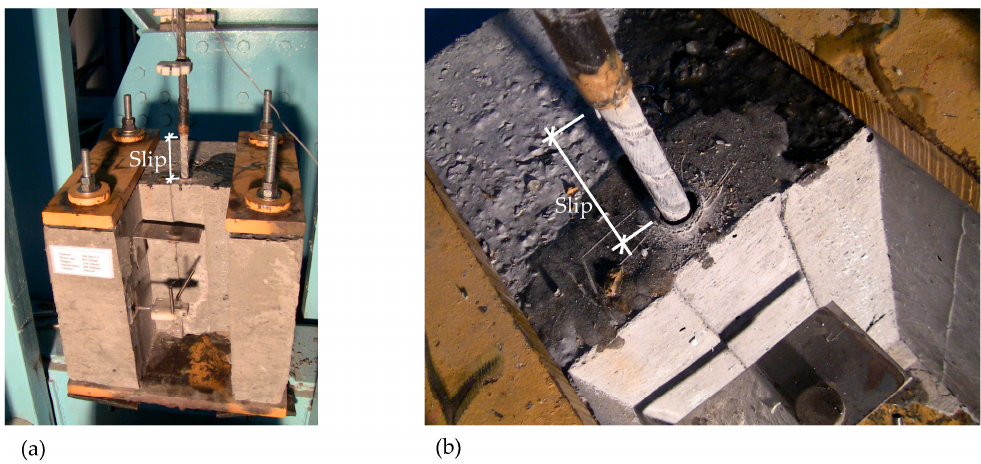
Figure 10. ( a ) Pullout failure; ( b ) No damage observed on concrete surface.